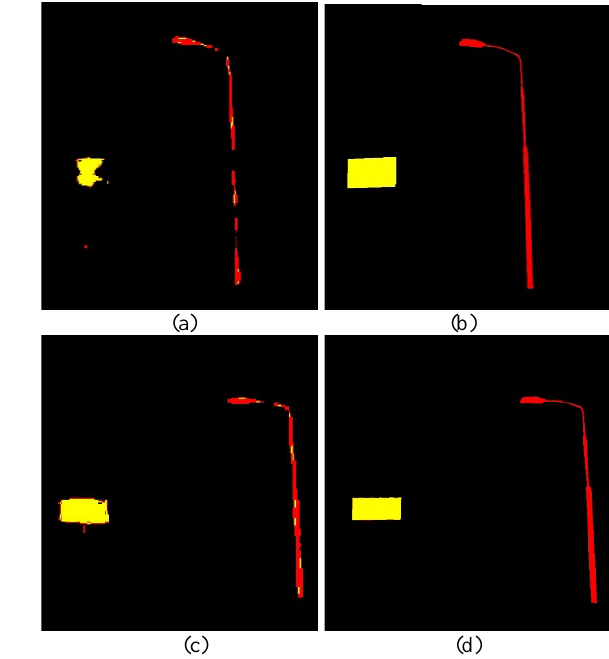
Figure 11. Predictions of fine-tuning. (a) (b) The prediction and labeled ground truth of panoramic images. (c) (d) The prediction and labeled ground truth of transformed images.